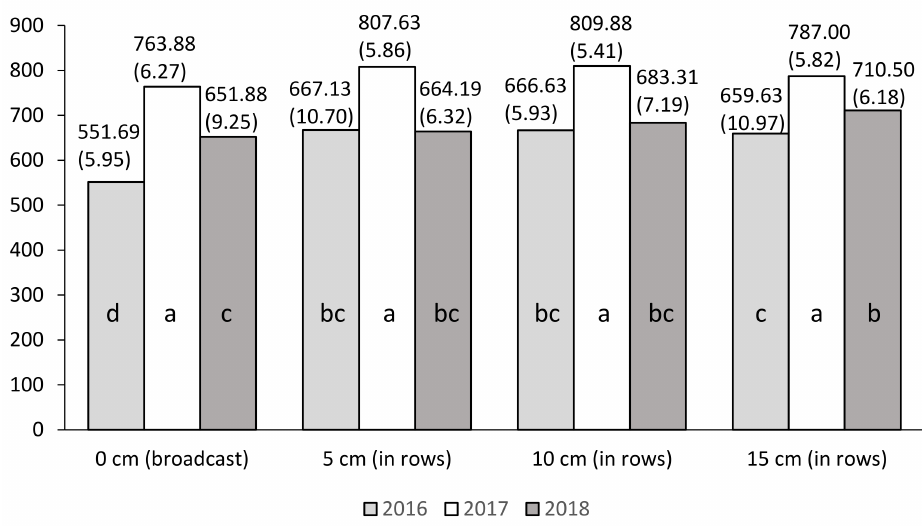
Figure 3. Mean values of index SPAD for the combinations of three years (Y) and four NP fertilizer sowing depths (A factor): BBCH 18/19. a, b, c, d: homogeneous groups ( p ≤ 0.05). Standard errors are in brackets.